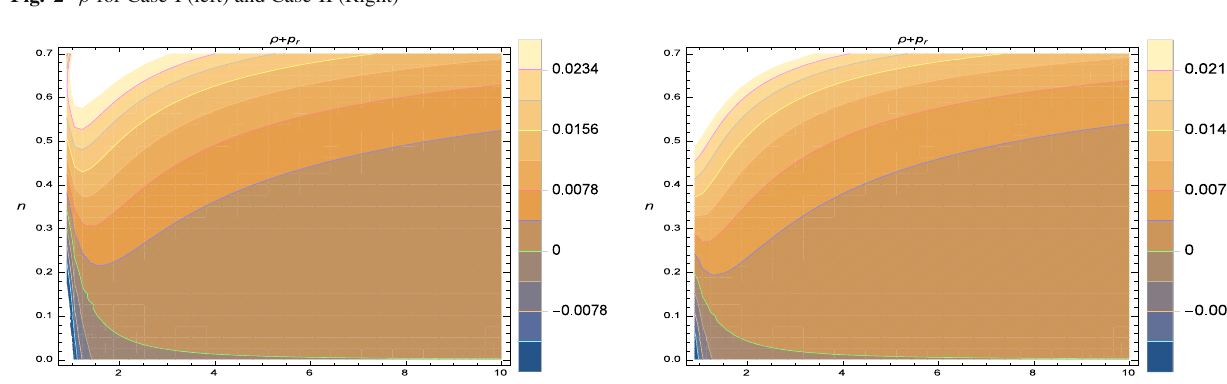
Fig. 2 ρ for Case-I (left) and Case-II (Right)